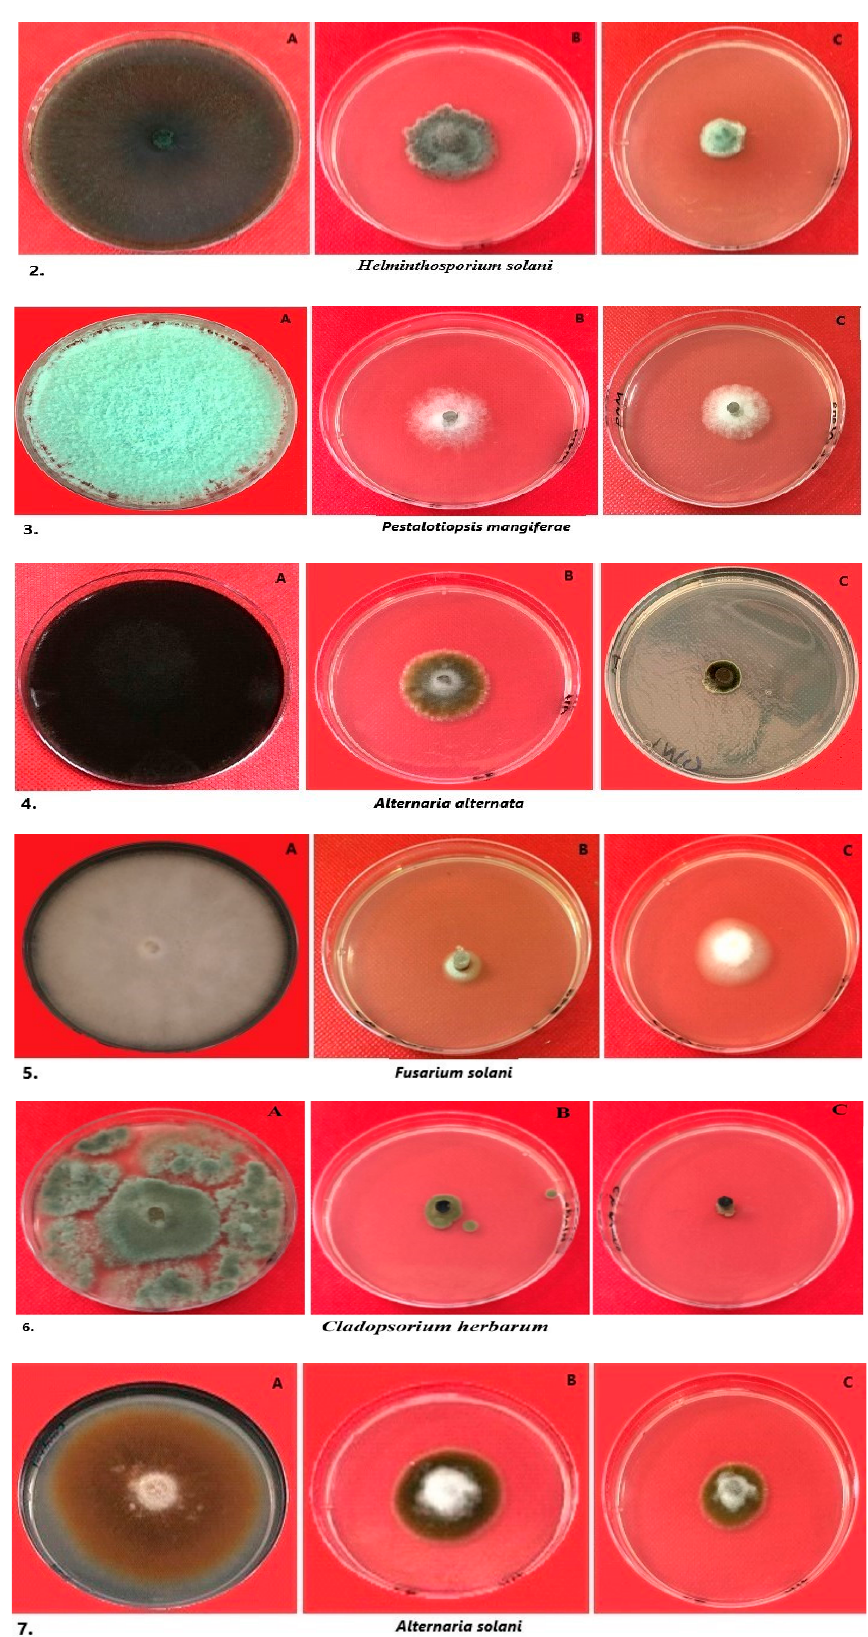
Figure 5. Antifungal activity of the synthesized Ag NPs against several pathogenic fungi: ( A ) mycelial growth in control plate (not treated); ( B ) treated with synthesized cranberry Ag NPs; ( C ) treated with fungicide (C + M-0.1%). 1–7: Fungal isolates. Table 1. The diameter of the colony growth of fungal isolates treated with cranberry Ag NPs, cran- berry extracts, AgNO 3 and the fungicide. Fungal Pathogens—Diameter of the Colony Growth (mm) Treatment F. oxysporum M. phaseolina P. mangiferae A. alternata F. solani C. herbarum A. solani Control—untreated 90.00 ± 0.00 90.00 ± 0.00 90.00 ± 0.00 90.00 ± 0.00 90.00 ± 0.00 90.00 ± 0.00 72.00 ± 1.52 Treated—Cb-AgNPs